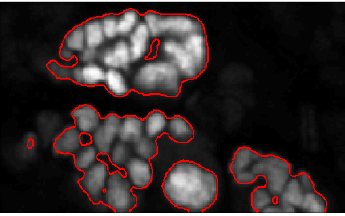
Figure 4. A superposition of the bounding contours on the original